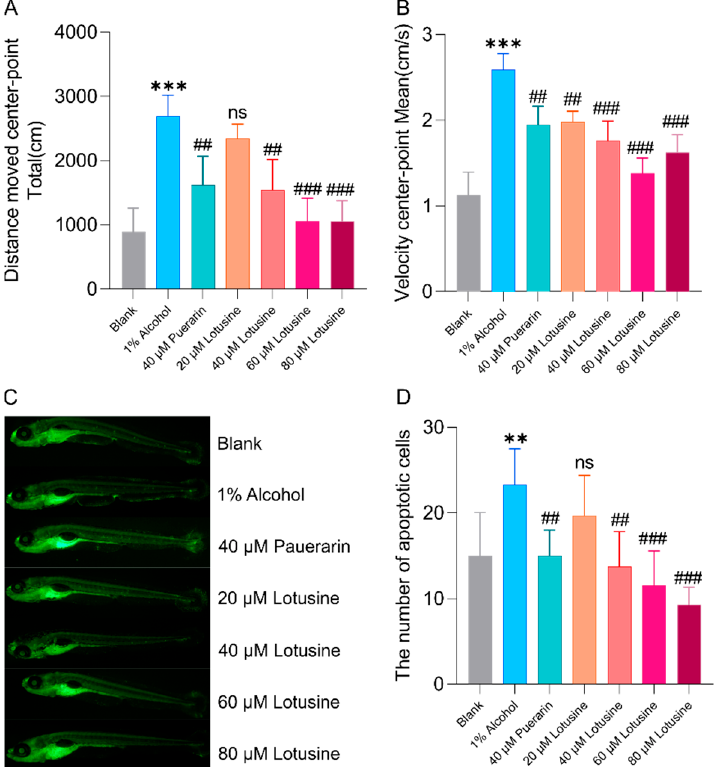
Figure 9. Characterization of the neuroprotective activity of lotusine. ( A , B ) zebrafish larvae behavior treated with lotusine. ( C,D ) The effect of lotusine on the neural cells of zebrafish larvae. ** p < 0.01 vs. blank; *** p < 0.001 vs. blank; ## p < 0.01 vs. alcohol exposure group; ### p < 0.001 vs. alcohol expose group; ns, not significant; n = 7.